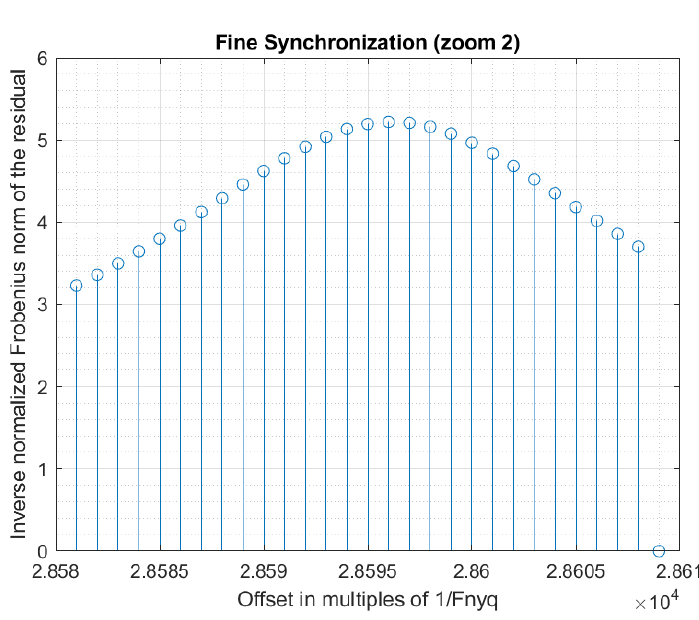
Figure 14. Synchronization (zoom